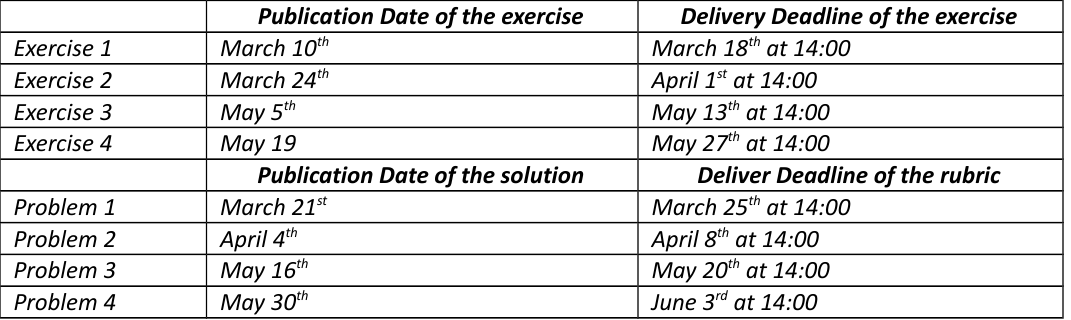
Table 1. Publication dates of the exercises and solutions posted on the virtual platform and delivery deadlines during the spring course in